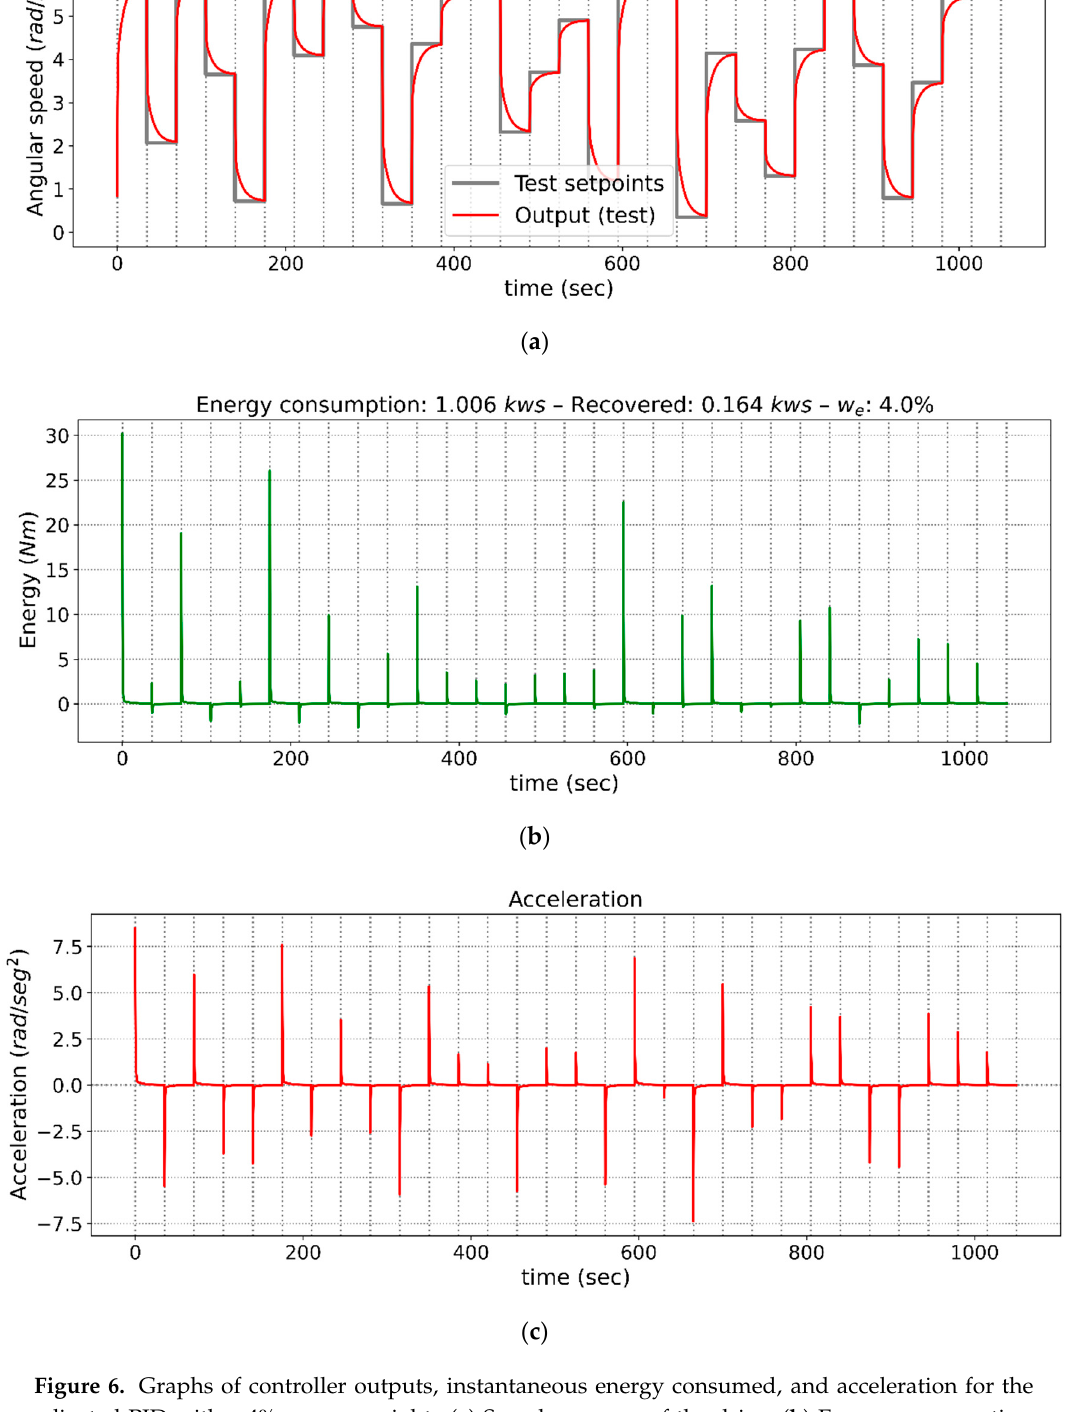
Figure 6. Graphs of controller outputs, instantaneous energy consumed, and acceleration for the adjusted PID with a 4% energy weight. ( a ) Speed response of the drive, ( b ) Energy consumption, ( c ) Acceleration of the